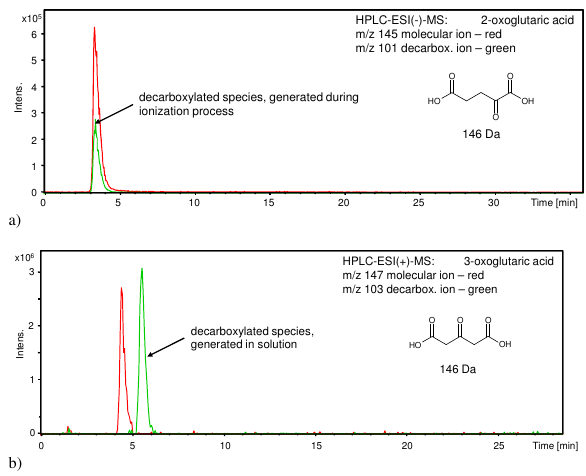
Fig. 13. HPLC-ESI( − /+)-MS extracted ion chromatograms of 2-oxoglutaric acid (a) and 3-oxoglutaric acid (b) . In the chro- matogram of 2-oxoglutaric acid, the signals from the product of decarboxylation and from the molecular ion are coincident (reten- tion time approximately 4.5min), indicating that the decarboxyla- tion occurred during the ionization process. In the chromatogram of 3-oxoglutaric acid the peak from the decarboxylated species ap- pears at a different retention time (5.5min), which shows that de- carboxylation occurred prior to the ionization. Note that due to sen- sitivity reasons (a) was measured in the negative ion mode whereas (b) was in the positive ion